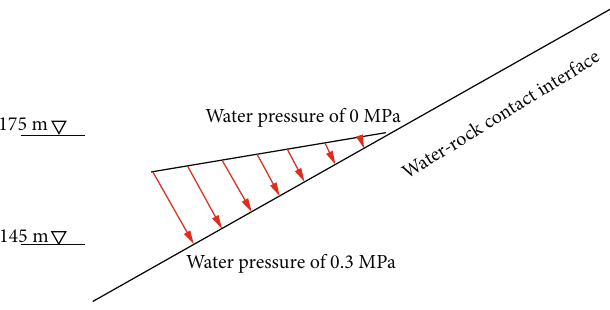
Figure 1: Water pressure distribution in fl uctuating zone of Three Gorges dam bank slide [20].